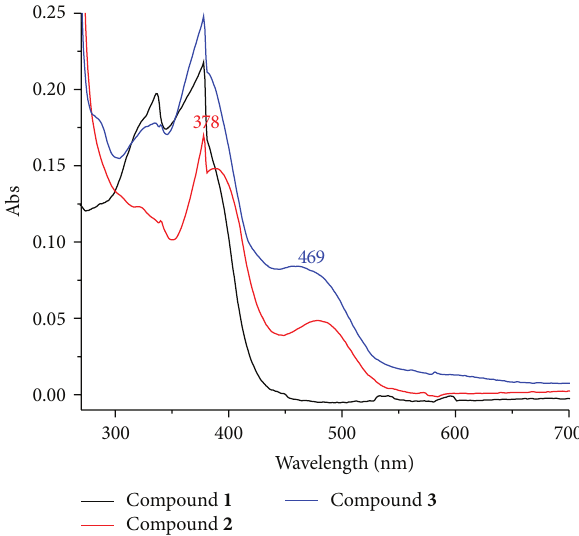
Figure 9: The UV-vis spectra of compounds 1 , 2 , and 3 . Figure 10: The UV-vis spectra of compounds 1 , 2 , and 3 exposure to UV light for 120